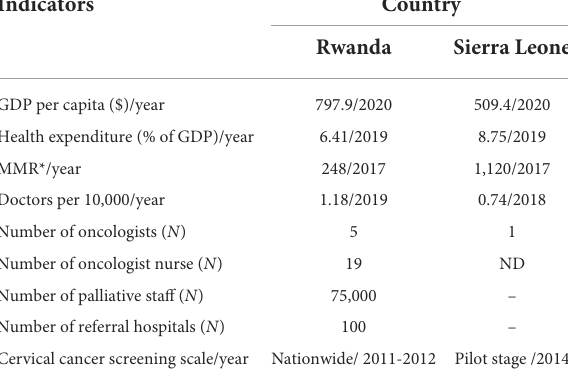
TABLE 1 General indicators of Rwanda and Sierra